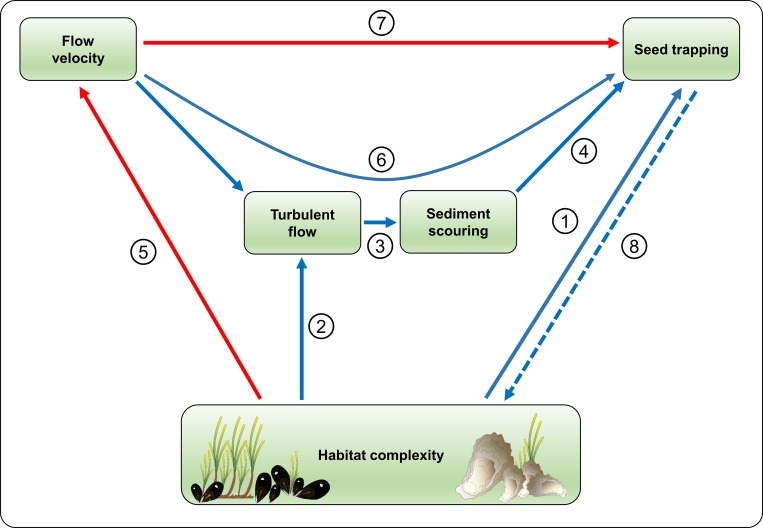
Conceptual diagram on interactions between habitat complexity, sediment scouring, flow velocity and seed trapping.Red arrows indicate negative effect, blue arrows indicate positive effect. Solid arrows correspond to direct effect; dashed arrows correspond to indirect and potential effect. (1) Trapping of eelgrass seeds increases with epibenthic complexity provided by e.g. eelgrass canopy or bivalves (Fig 2; S1 Table; S2 Table); (2) Turbulent conditions increase with complexity of the system (Fig 5B); (3) An increase in turbulence can cause erosion processes [36, 48], increasing surface complexity; (4) Surface complexity increases seed trapping (Fig 4); (5) Epibenthic complexity negatively affects flow velocity (Fig 5A); (6) Flow velocity increases the effect of habitat complexity on turbulent flow (Fig 5B) and sediment scouring (Fig 2D–2F; S4 Table), thus contributing indirectly to seed trapping; (7) The direct effect of flow velocity on seed trapping is assumed negative (Fig 4, [38]); (8) As there is a density dependent effect of eelgrass shoots on seed trapping, while germination success of seeds is independent of density [56], we suggest the existence of a positive feedback over time, facilitating eelgrass patch emergence. Symbols from IAN Symbol Libraries.